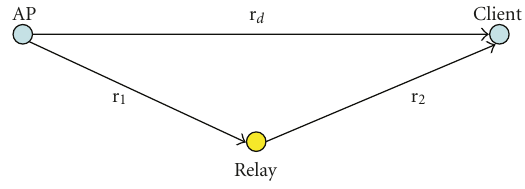
Figure 2: Illustration of relaying.